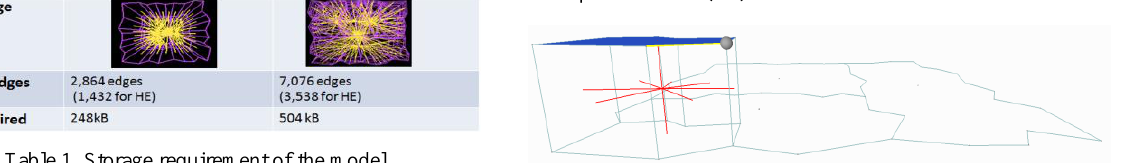
Table 1. Storage requirement of the model